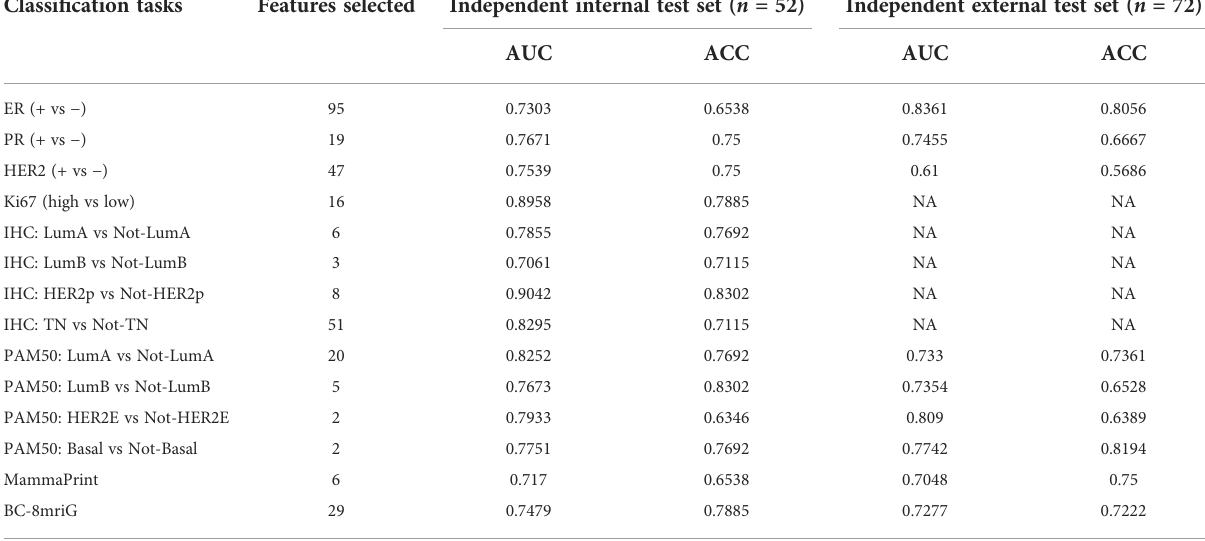
TABLE 2 Predictive performance of classi fi ers based on DCE-MRI features. Classi fi cation